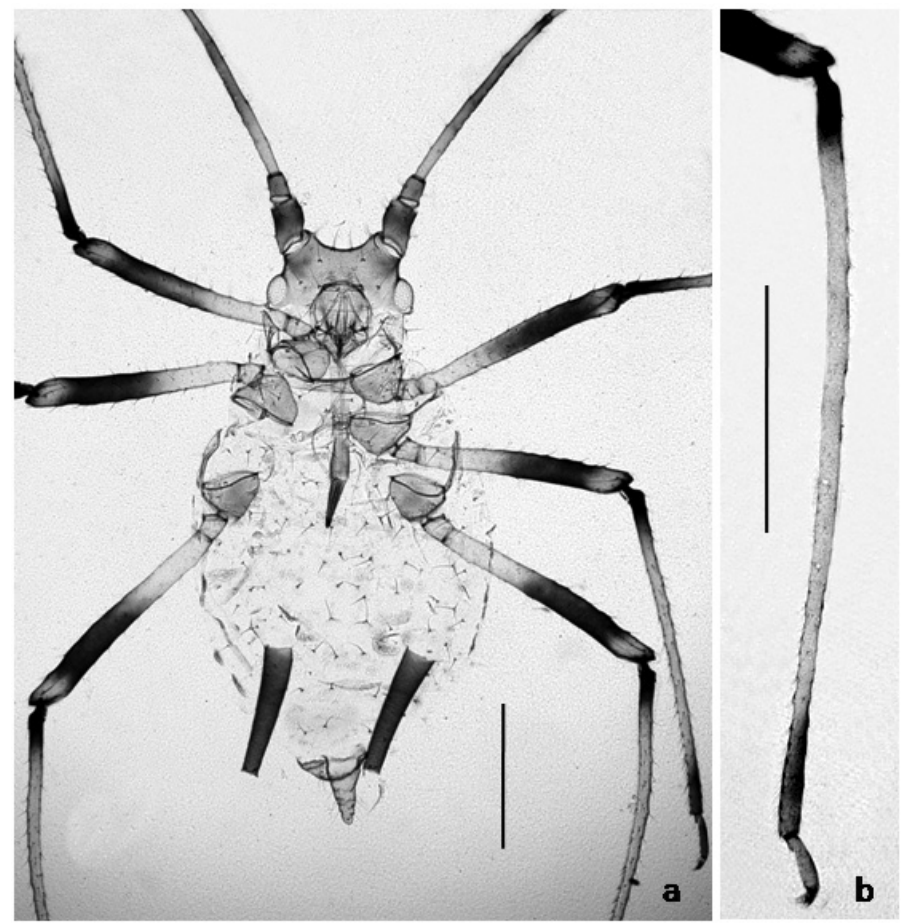
Figure 1. a Macrosiphoniella remaudierei sp. n., apterous viviparous: body shape and pigmentation b hind tibia. Scale bars 0.5